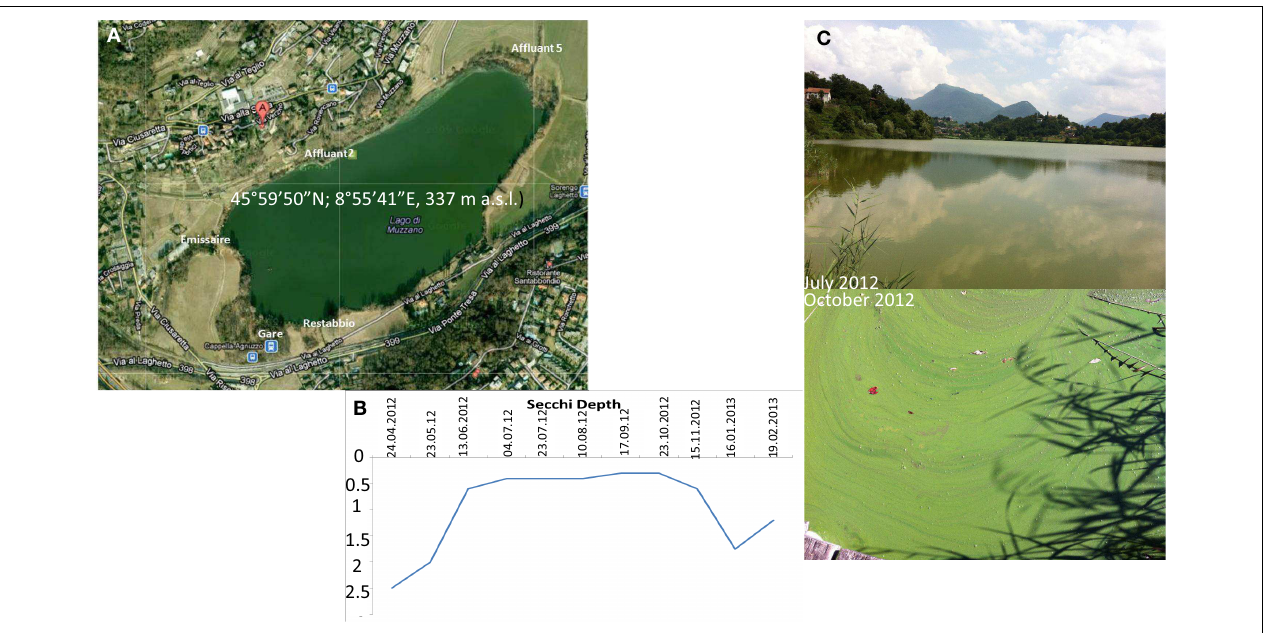
FIGURE 1 | (A) Lake Muzzano and its inflows (Affluant 5 being the larger one, Affluant 2, Restabbio, and Gare being non-permanent ones) and its outflow (Emissaire). (B) Secchi depth (m) and (C) Pictures of the lake in July and October 2002 showing Microcystis algal